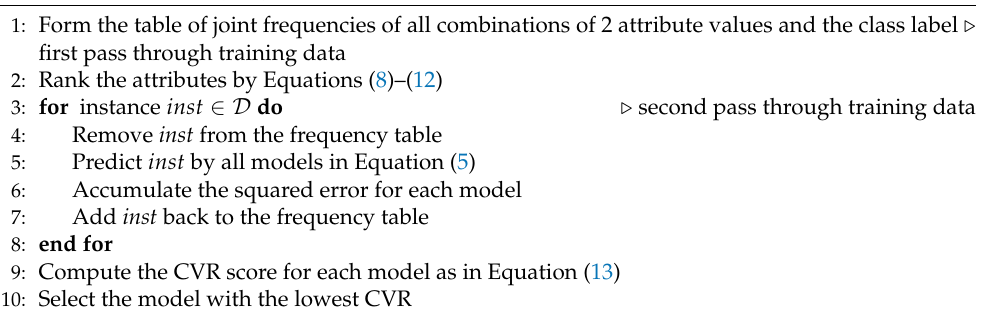
Algorithm 1 Training algorithm of attribute selective